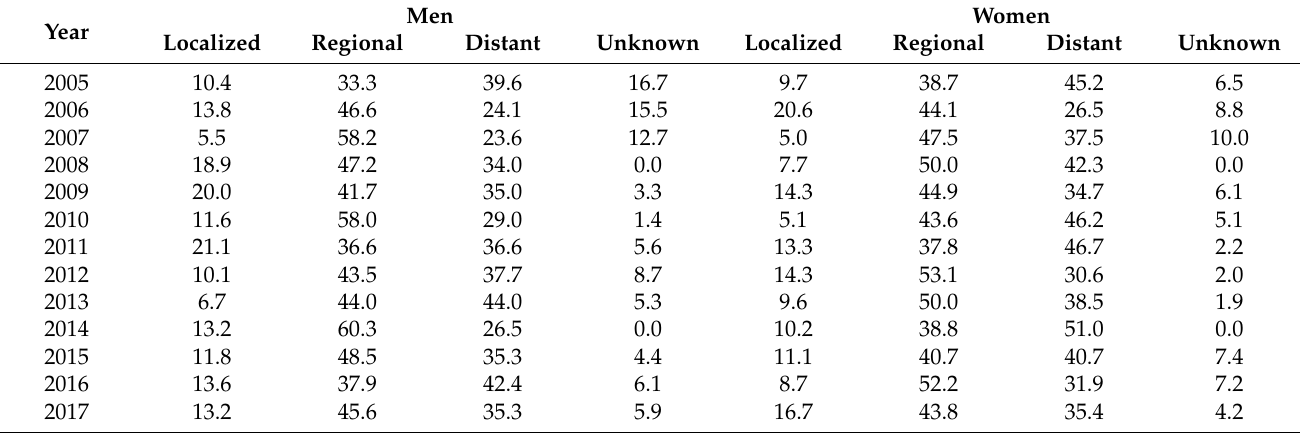
Table 3. SEER summary stages of colon signet-ring cell carcinoma between 2005 and 2017. Men Women Year Localized Regional Distant Unknown Localized